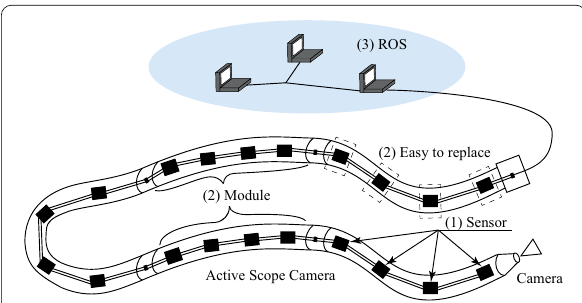
Fig. 1 Schematic of the three design principles of sensor-integration system. (1) Sensors are daisy-chained to accommodate multiple